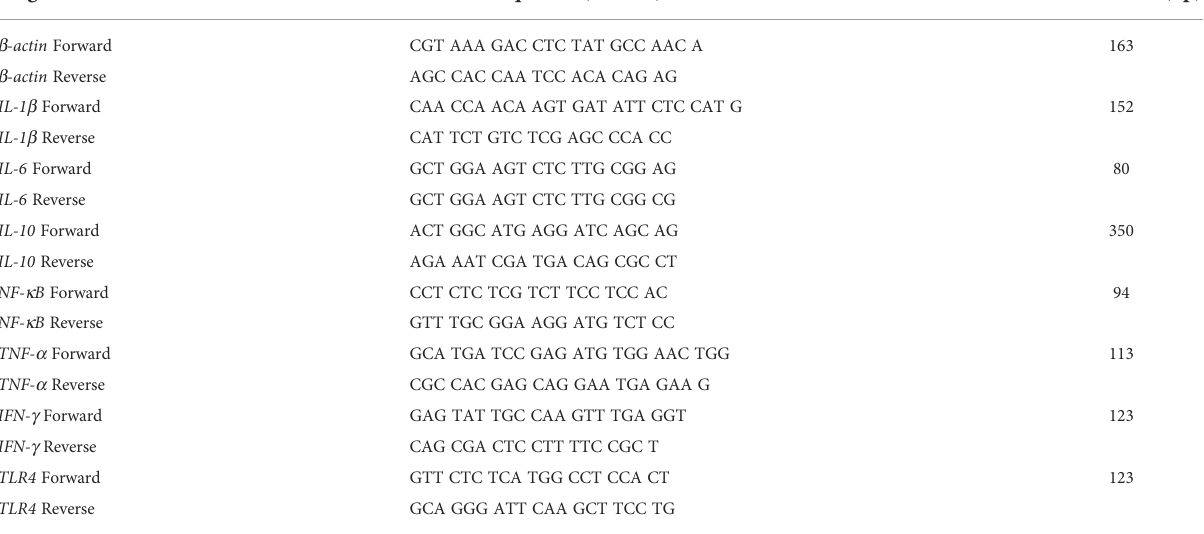
TABLE 1 Primers for